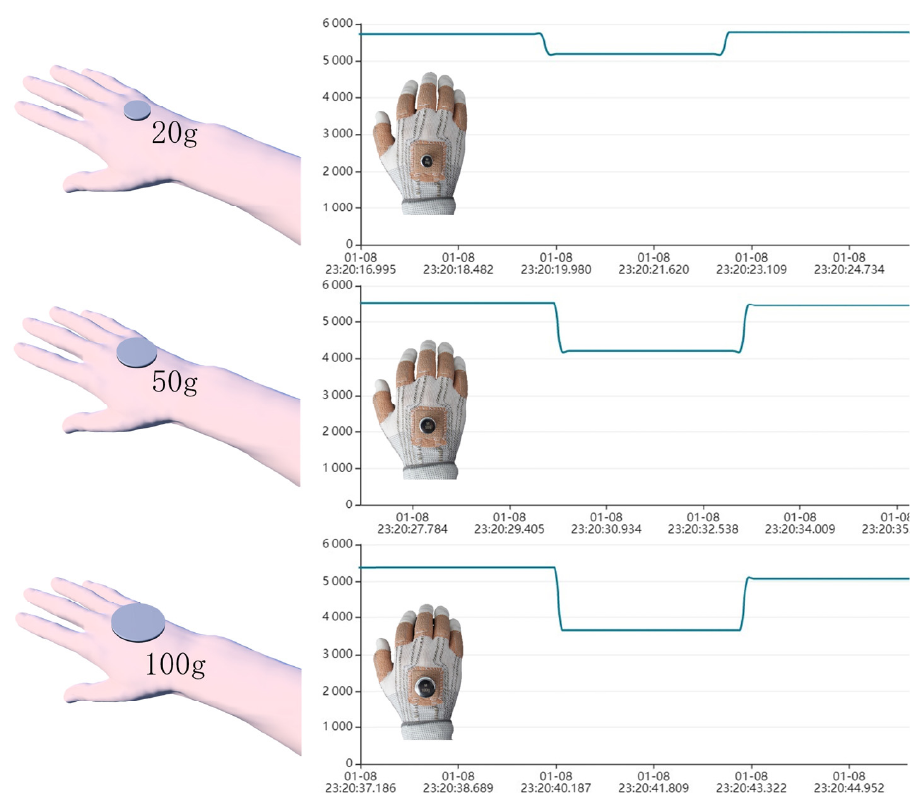
Figure 9. Demonstration of practical application: pressure signal monitoring.